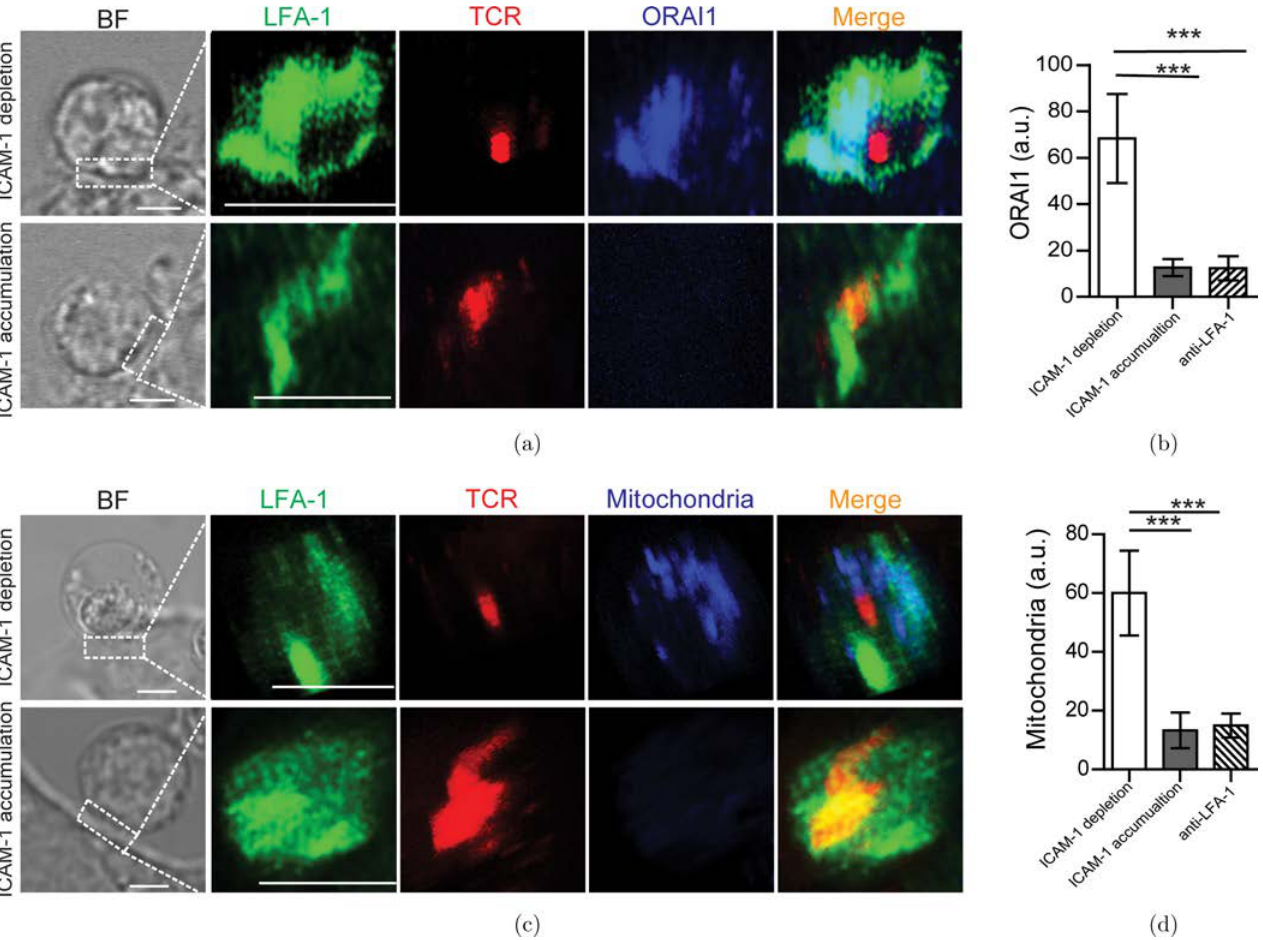
Fig. 6. The co-localization of ORAI1, mitochondria and LFA-1 in mature ISs with ICAM-1 depletion or immature ISs with only ICAM-1 accumulation: (a) The localization of ORAI1 and LFA-1 in a mature IS (bullseye IS) and an immature IS. Bar ¼ 2 (cid:2) m. (b) The °uorescence of ORAI1 in the mature IS, immature IS, and IS with anti-LFA-1 antibody treatment. (mean (cid:4) s.e.m., n ¼ 25, three independent experiments), *** p < 0 : 001 (two-tailed Student's t -test). (c) The localization of mitochondria and LFA-1 in a type of mature IS (bullseye IS) with ICAM-1 depletion or immature IS with only ICAM-1 accumulation. (d) The °uorescence of mitochondria in the mature IS, immature IS and IS with anti-LFA-1 antibody treatment. (mean (cid:4) s.e.m., n ¼ 25, three independent experiments), *** p < 0 : 001 (two-tailed Student's t